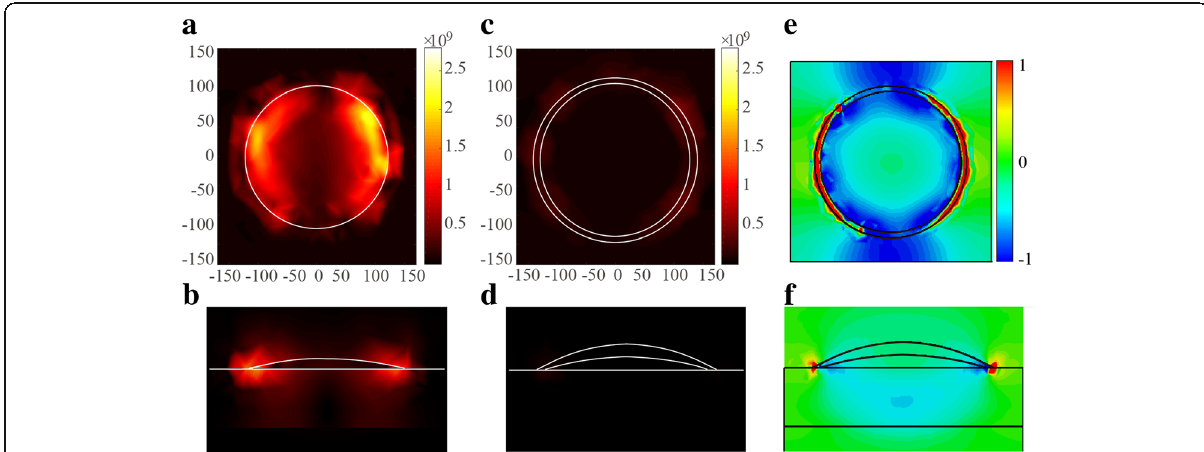
Fig. 4 Simulated electric field distributions of a , c Ag and b , d Ag-Cu absorbers from the top and yz cross-section view, respectively. The Ag-Cu absorber ’ s E y in TE mode is shown in e and